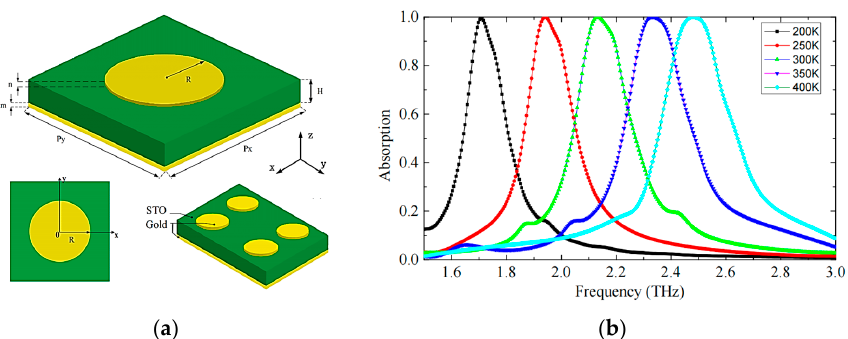
Figure 28. ( a ) The proposed tunable terahertz absorber with a classical sandwiched structure consisted of a metallic top layer and ground plane, spaced by STO material film; ( b ) absorption spectra of the absorber with different temperatures of 200 K, 250 K, 300 K, 350 K, and 400 K under normal incidence [66].